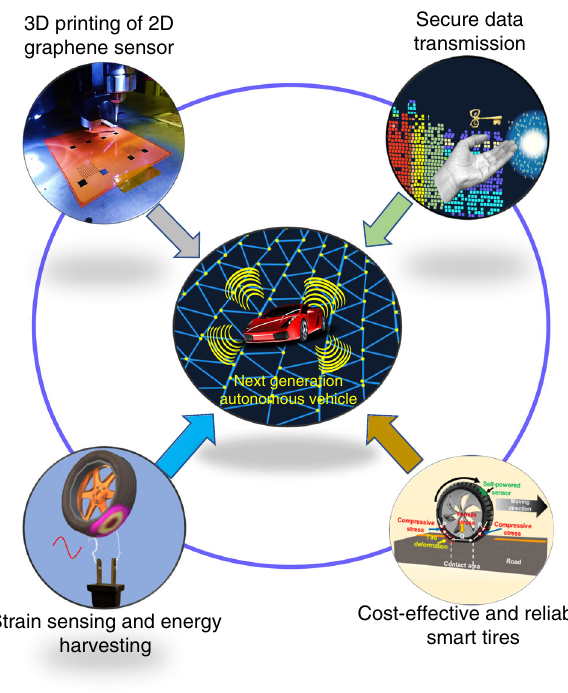
Fig. 1 Overview of the present work. Smart tires with innovative 3D printed graphene-based strain sensors, secure data transfer, and strain energy harvesting for next generation of autonomous